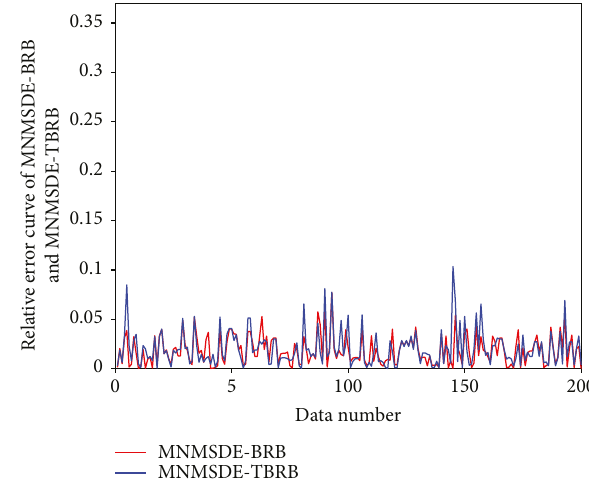
Figure 5: The testing samples and output of original BRB.